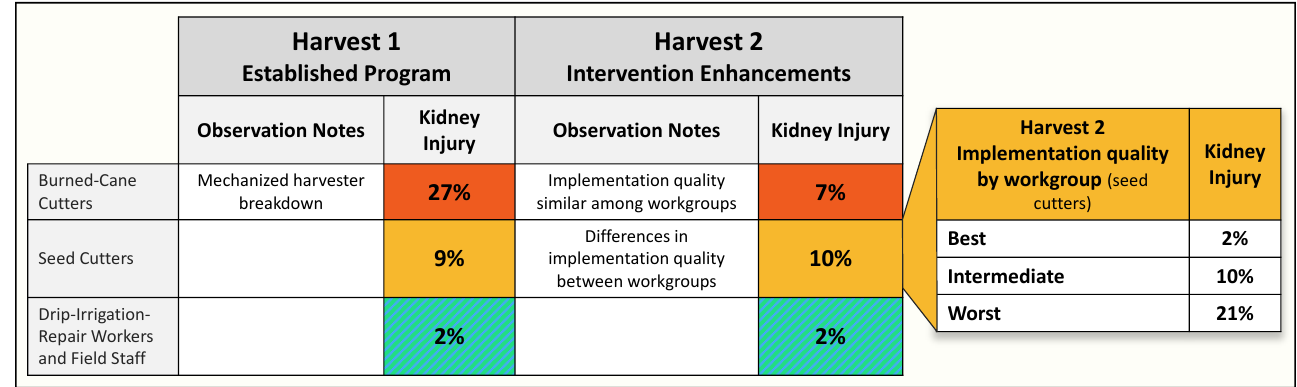
Figure 2. Change in cross-harvest kidney injury between Harvest 1 and Harvest 2. Significant workgroup differences only seen within seed-cutter job type (adapted from reference [15]).